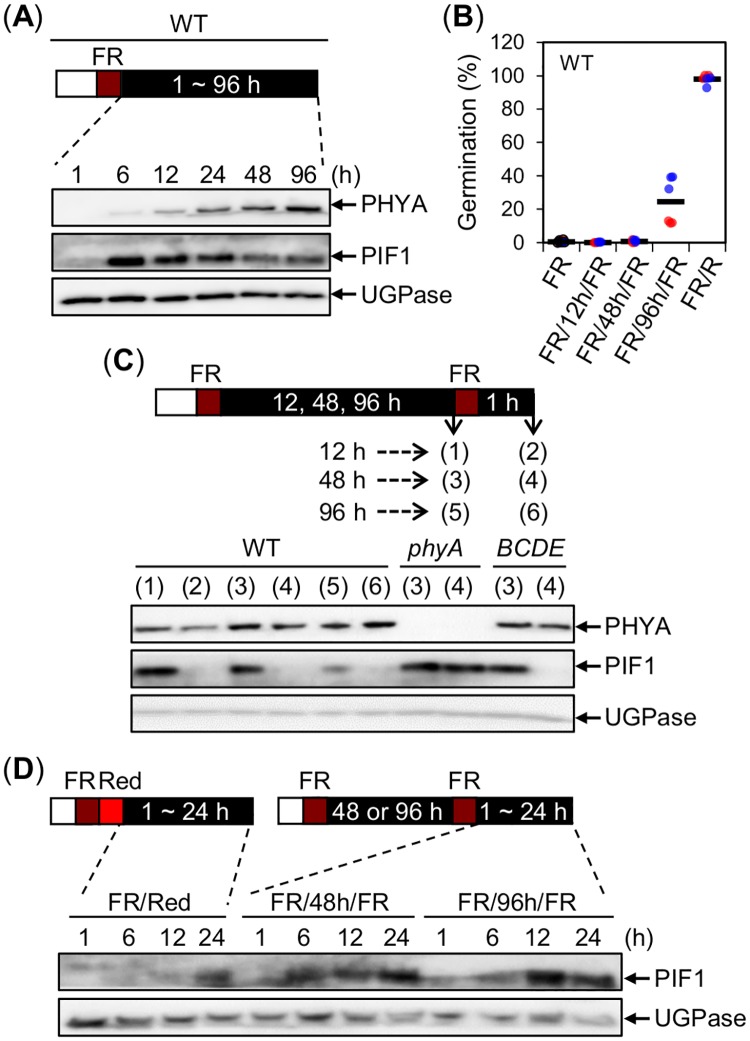
PIF1 extinction time is shorter after FR light irradiation than after R light irradiation.(A) Protein gel blot analysis of phyA and PIF1 protein levels in WT seeds exposed to a FR assay at the indicated time points after the FR light pulse. (B) Germination percentage of WT seeds exposed to a FR, FR/12h/FR, FR/48h/FR, FR/96h/FR or FR/R assay. Two independent biological replicates were used and are represented with an individual color each (red or blue). For each biological replicate, three technical repetitions of the germination percentage of 50–65 seeds are shown by a colored dot (red or blue). The average germination percentage for all the technical repetitions is represented by a horizontal black bar. (C) Protein gel blot analysis of phyA and PIF1 protein levels in WT, phyA and phyBCDE (BCDE) seeds exposed to a FR/12h/FR, FR/48h/FR or FR/96h/FR assay just before the second FR light pulse and thereafter as indicated. (D) Protein gel blot analysis of PIF1 protein levels in WT seeds exposed to a FR/R, FR/48h/FR or FR/96h/FR assay at the indicated time points after the R or second FR light pulse. For (A, C and D) UGPase protein levels were used as a loading control. All experiments were repeated with biological replicates, which provided similar results.